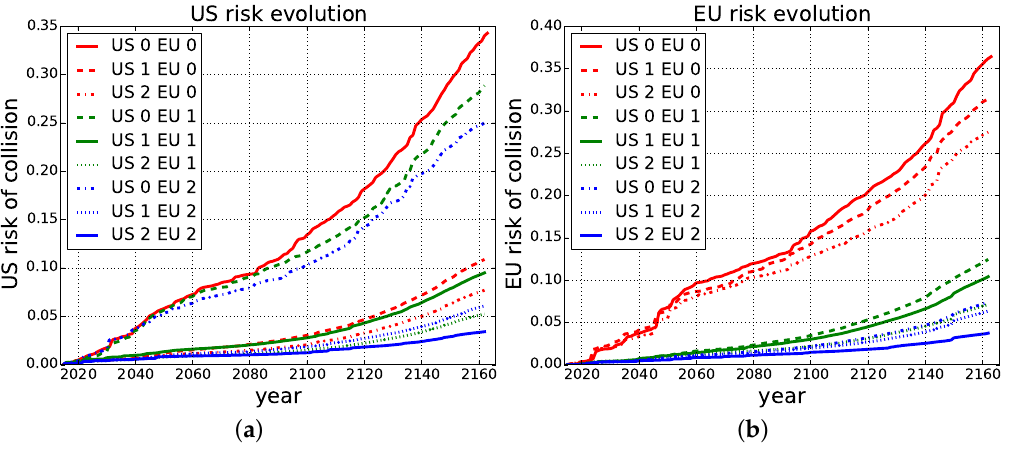
Figure 5. Evolution of overall risk to important assets for different combinations of actions of both the U.S. and EU. ( a ) Risk to U.S. assets; ( b ) risk to EU